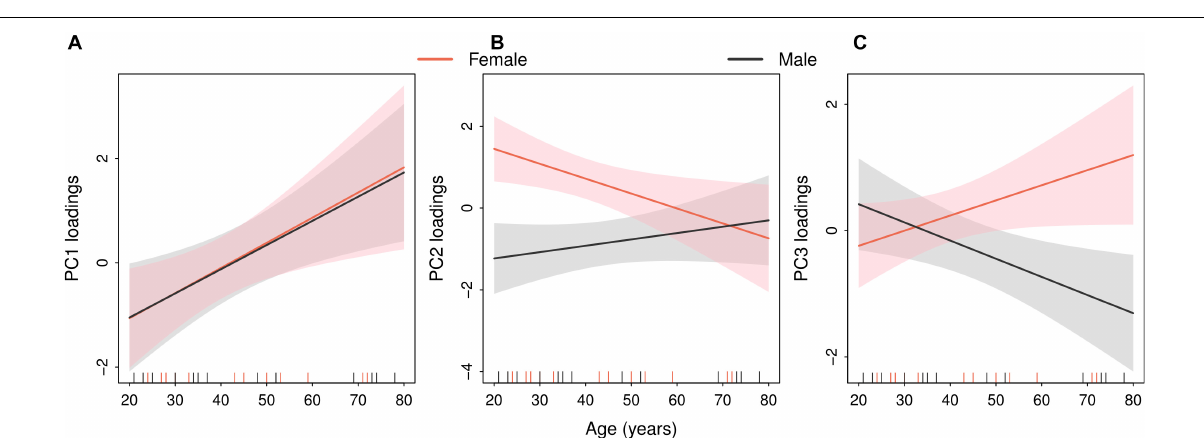
FIGURE 7 | Sex-specific linear relations between age and the three main principal components linking the dynamics of Chesttemp and Coretemp rhythms. Estimated regression lines (solid lines) with 90% confidence bands (shaded areas) in males (black) or females (red). The vertical dashes in the abscissa indicate the age of each of the 33 subjects in ST2. (A) PC1 loadings, (B) PC2 loadings, and (C) PC3